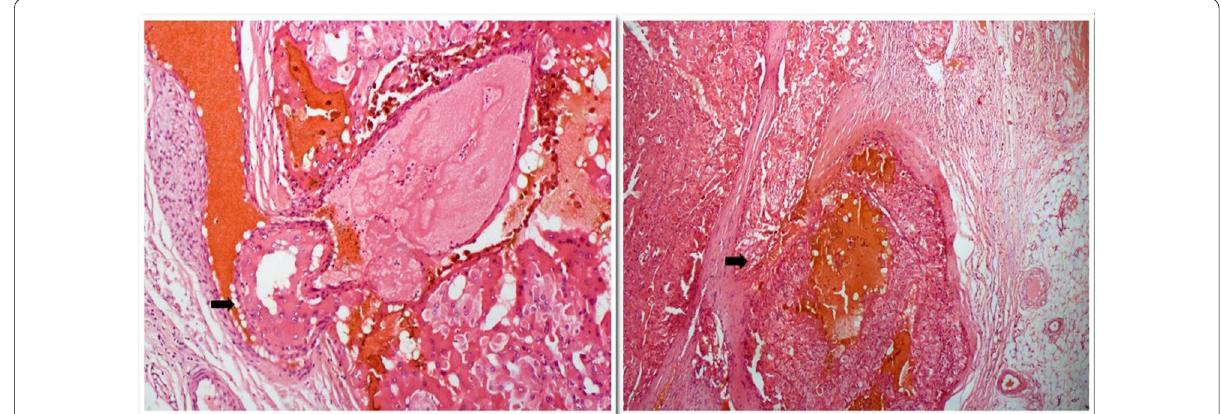
Fig. 5 H & E stain 100 showing sections of the lymph node with tumor infiltration into blood vessels ×